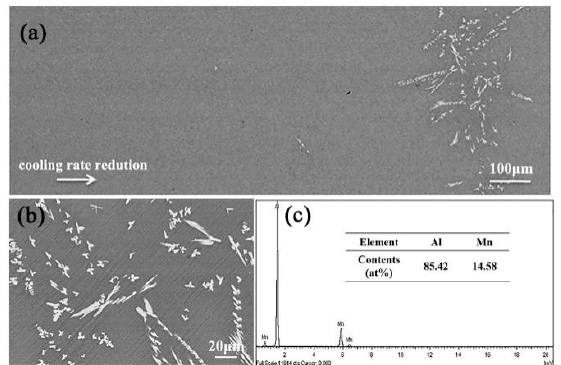
Figure 2. Microstructures of cross-section of the cylindrical sample in suction casting Al–4 wt.% Mn alloy: ( a ) SEM backscattered electron (BSE) image; ( b ) SEM BSE at partial magnification; ( c ) energy-dispersive spectroscopy (EDS).